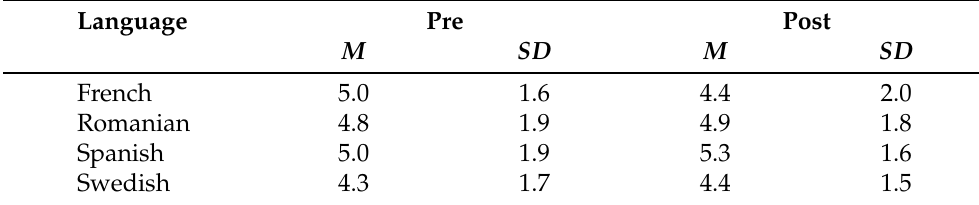
Table A4. I rely on news source/brand’s reputation.